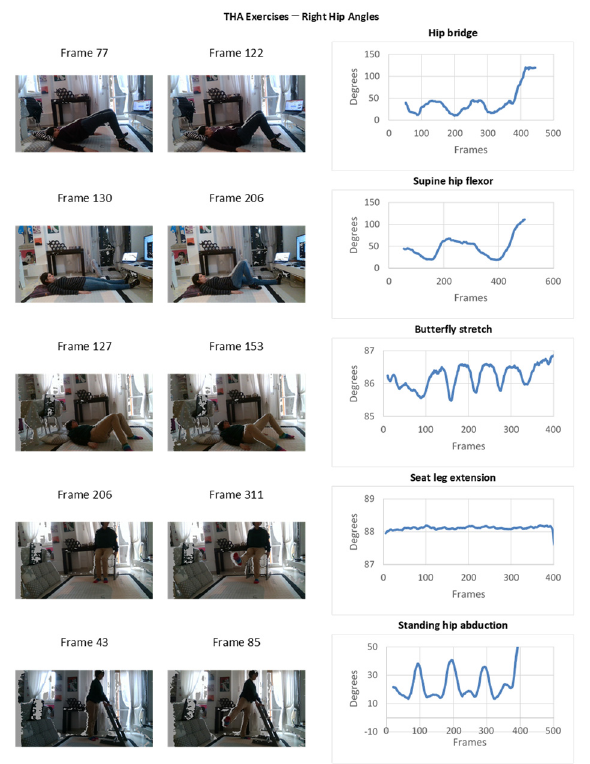
Figure 10. Experimental results of the monitoring in a domestic THA post-operative environment.